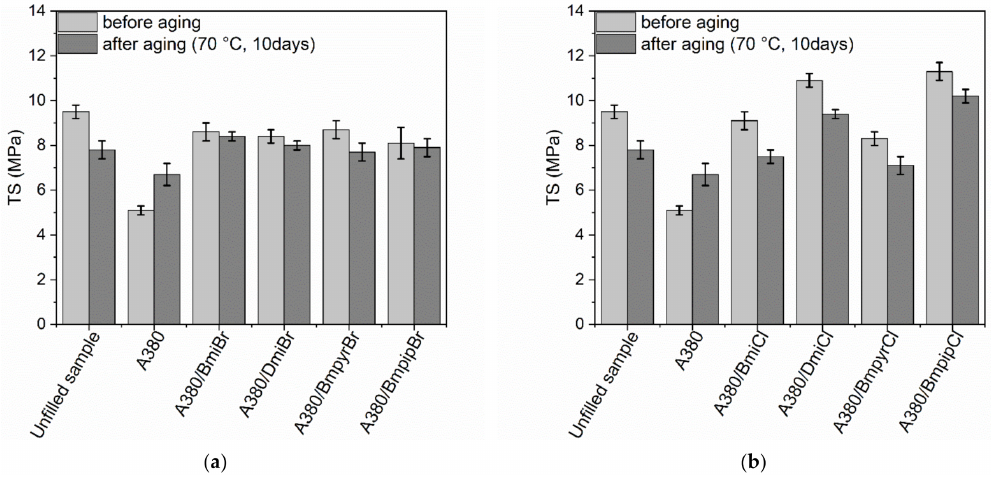
Figure 6. Influence of thermo-oxidative aging on the tensile strength (TS) of the silica-filled NR vulcanizates containing ILs with: ( a ) bromide anion; ( b ) chloride anion.